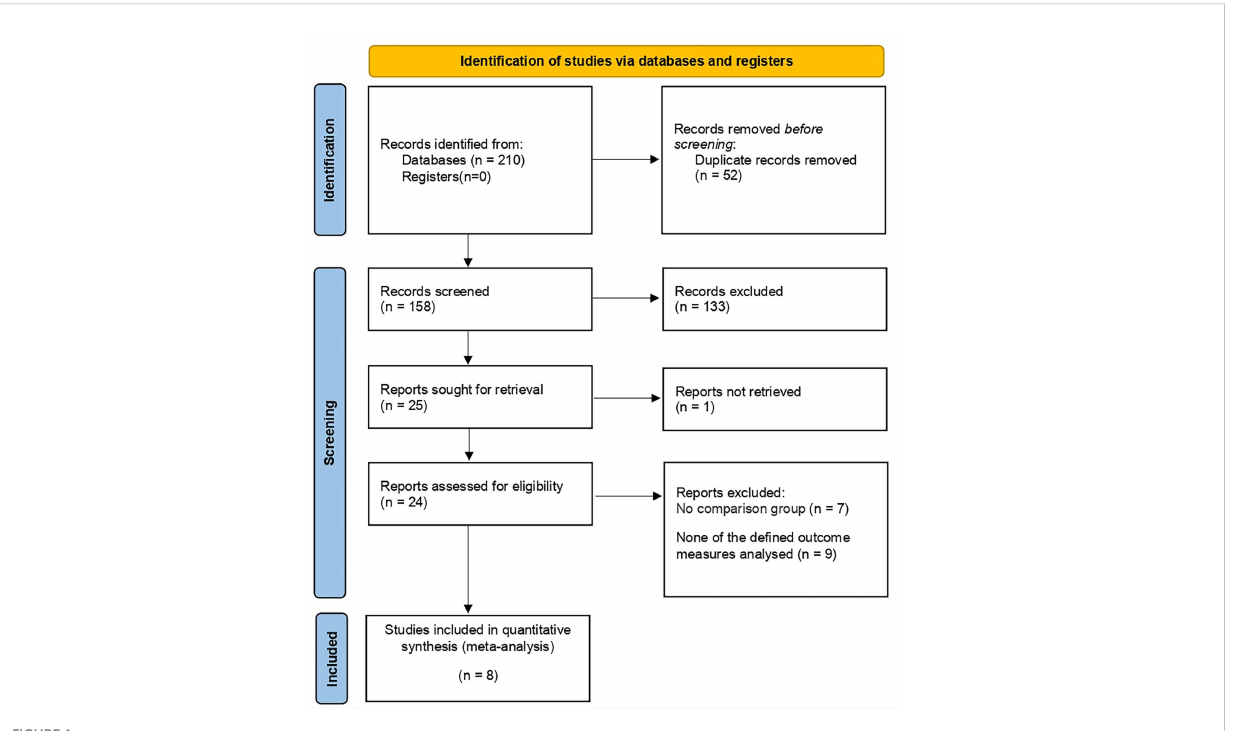
FIGURE 1 Literature screening fl